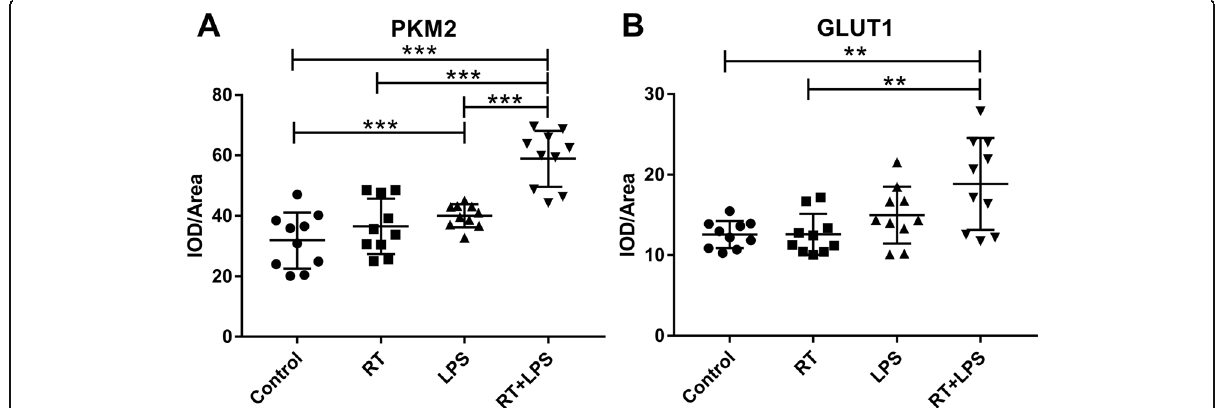
Fig. 5 Integral optical density (IOD)/area of PKM2 ( a ) and GLUT1 ( b ) in the four treatment groups: control, radiotherapy (RT)-only, lipopolysaccharide (LPS)-only, and RT+LPS groups. ** P < 0.01, *** P < 0.001